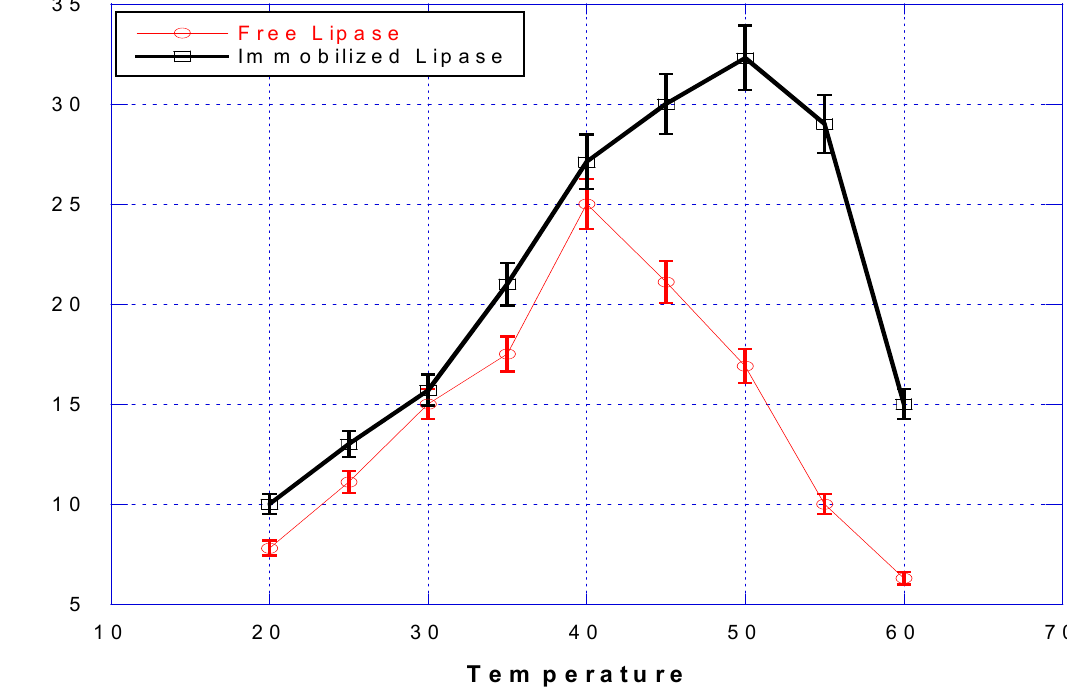
Figure 3. Effect of temperature (°C) on the activity of free ( red line ) and immobilized ( black line ) lipases at pH 8.0.